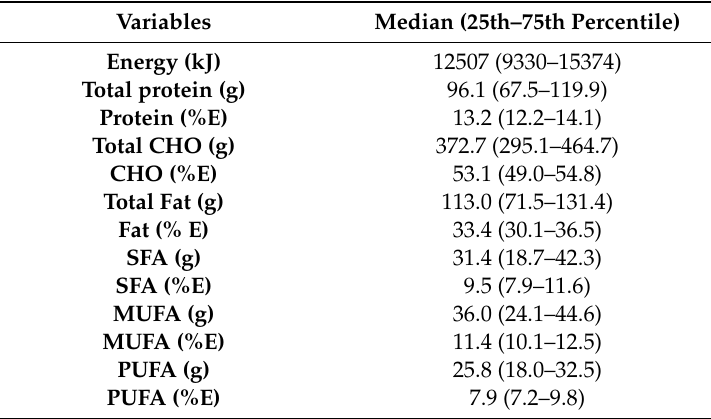
Table 2. Dietary energy, macronutrient and fatty acid